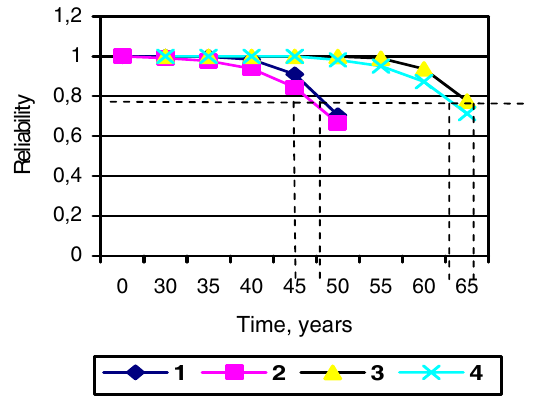
Fig 4 . Probability of serviceability of polymer coatings of d pc. 0 = 1mm in NaCl solutions: 1 – d min = 0,10, V d = 0,15; 2 – d min = 0,10, V d = 0,25; 3 − d min = 0,05, V d = 0,15; 4 − d min = 0,05, V d =